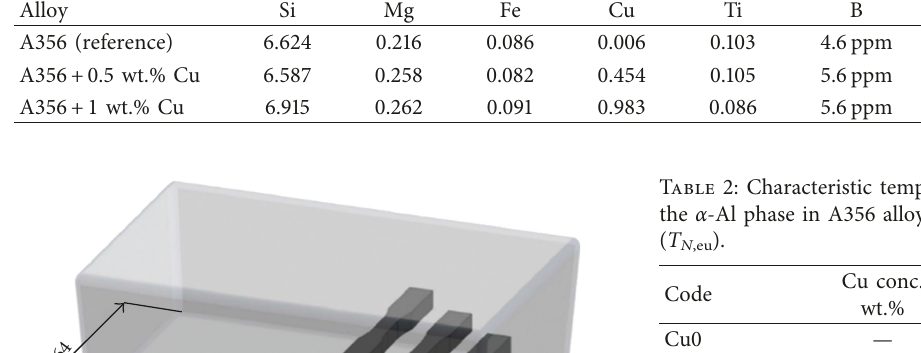
Table 1: Chemical composition (wt.%) of A356 reference alloy and Cu-containing alloys as measured by OES and their classification. Alloy Si